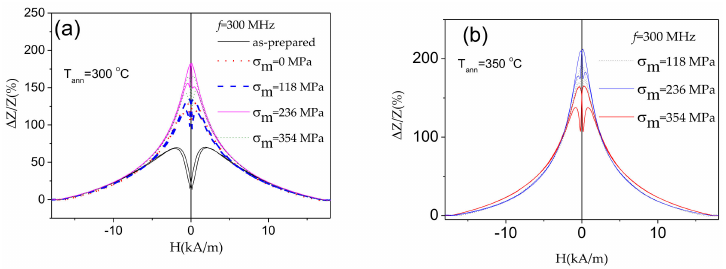
Figure 5. ∆ Z / Z(H) dependencies of as-prepared and stress-annealed at di ff erent σ m at T ann = 300 ◦ C ( a ) and T ann = 350 ◦ C ( b ) Co 69.2 Fe 3.6 Ni 1 B 12.5 Si 11 C 1.2 Mo 1.5 microwires measured at 300 MHz.